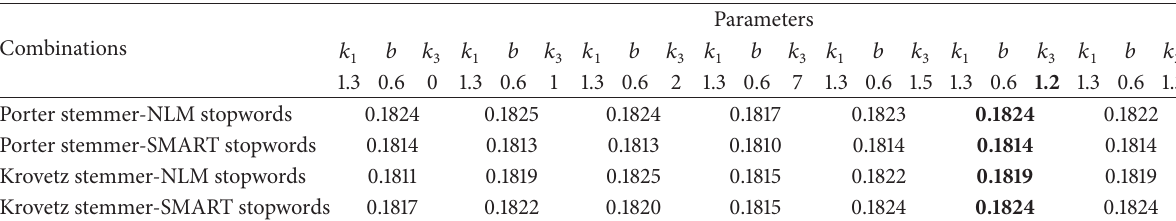
(c) The best value obtained for the 𝑘 3